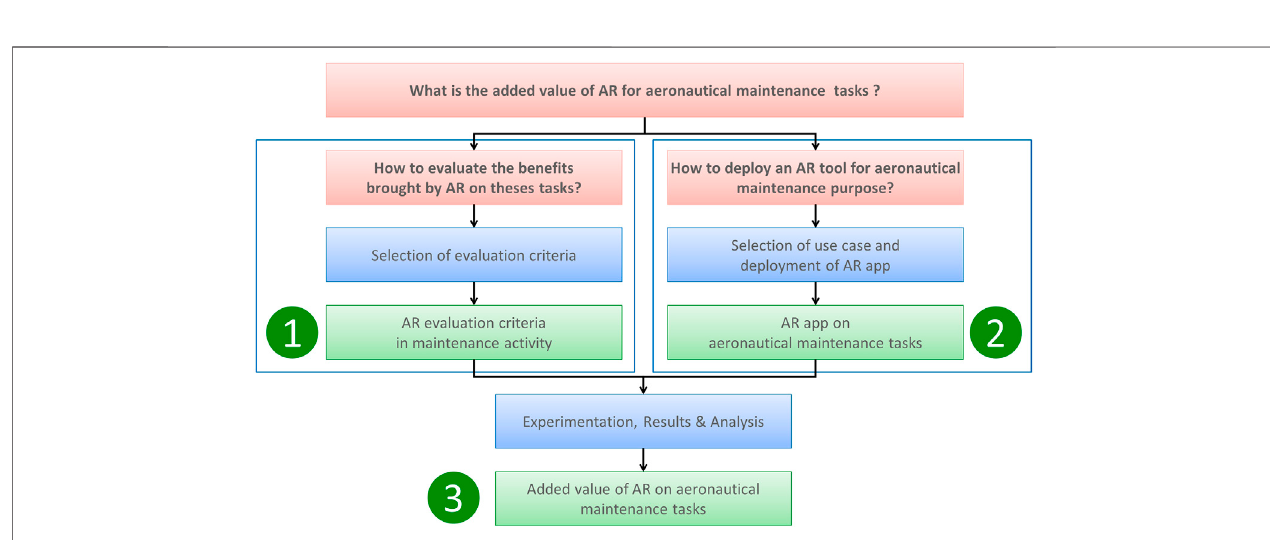
FIGURE 3 | Methodology to set up and conduct fi eld evaluation of the impact of AR tools for workers for aeronautical maintenance activities.